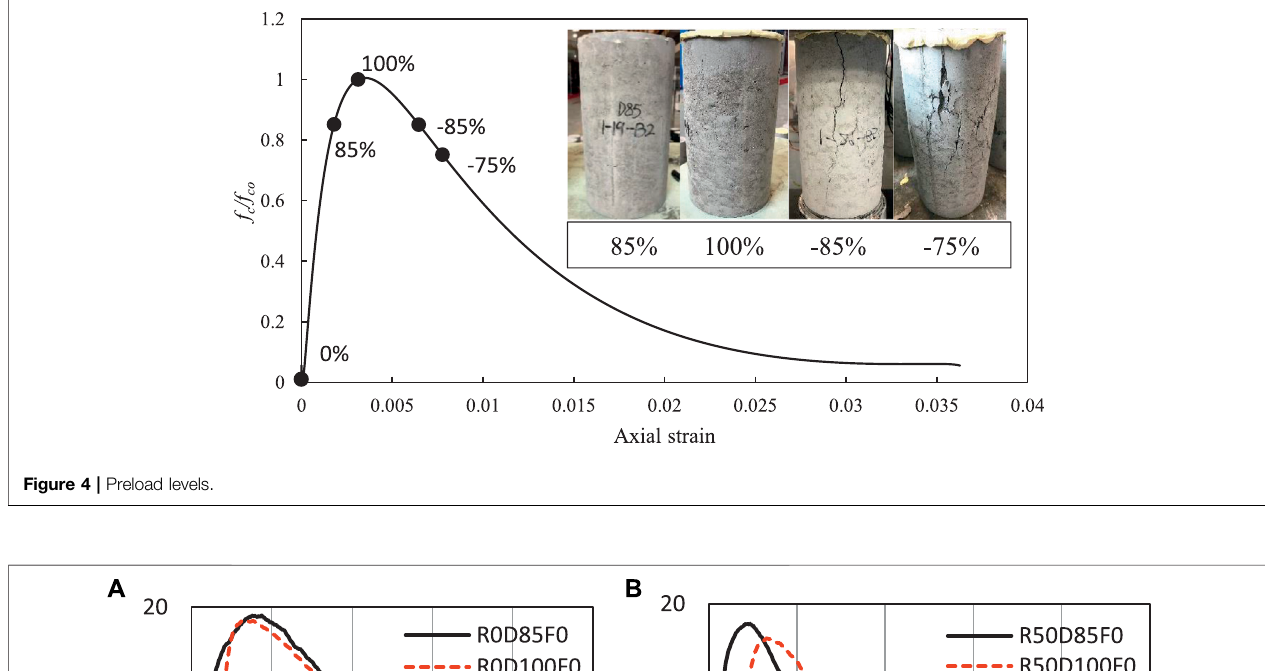
Figure 4 | Preload levels.